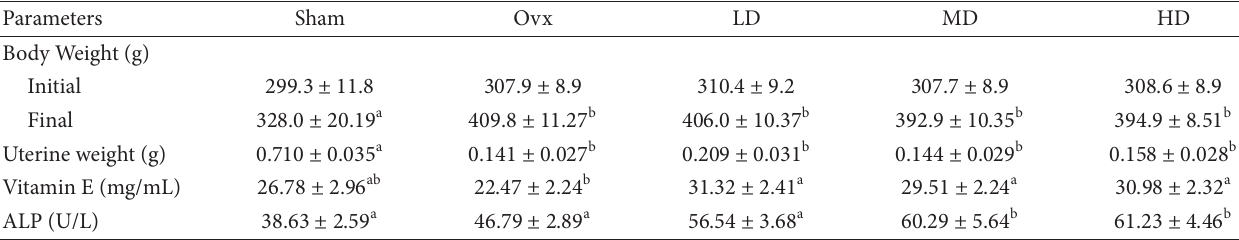
Table 1: Effects of ovariectomy (Ovx) and three doses of vitamin E: low dose (LD, 300 mg/kg diet), medium dose (MD, 525 mg/kg diet), and high dose (HD, 750 mg/kg diet) on body and tissue weights, serum vitamin E, and serum ALP activity.